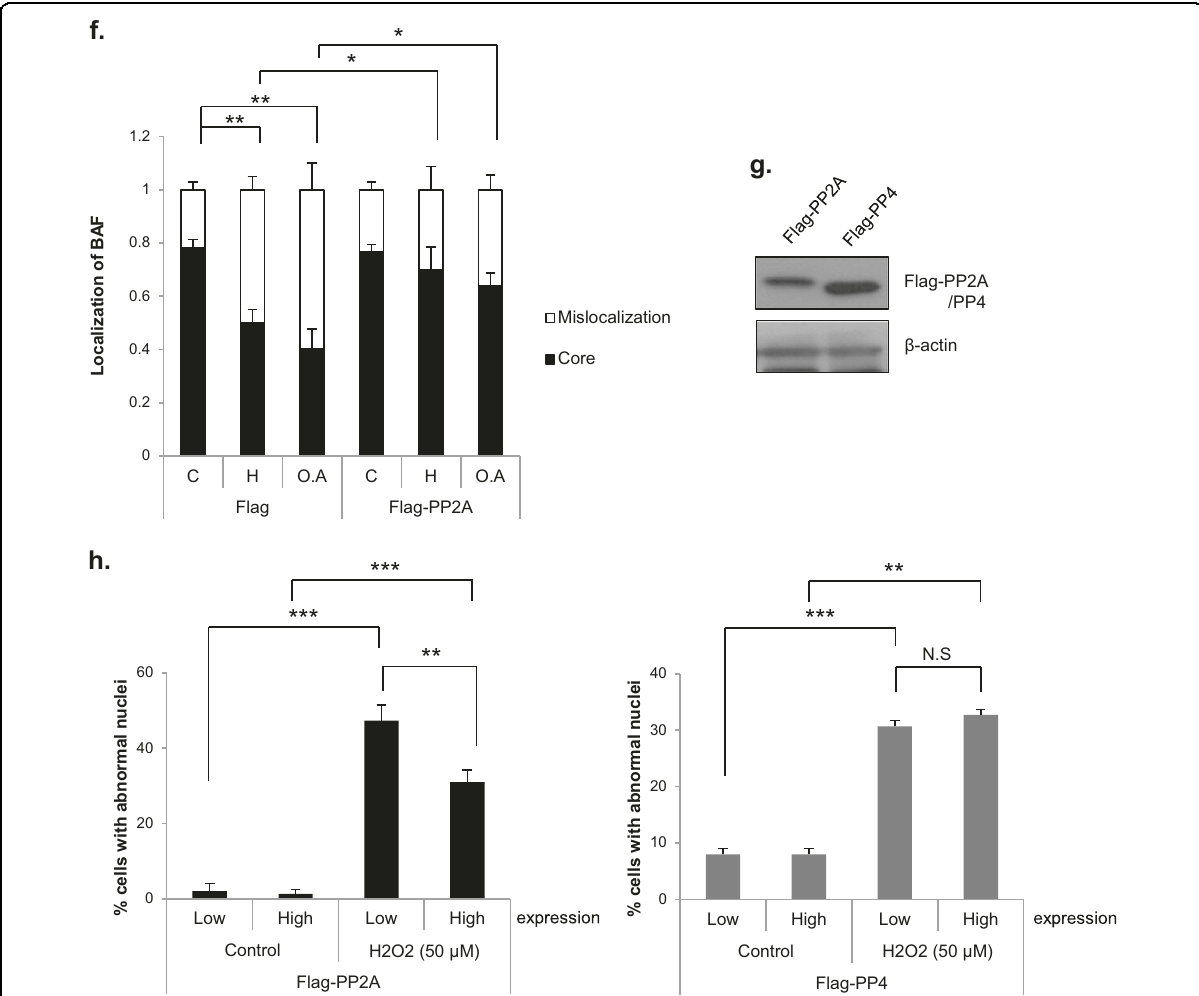
Fig. 7 Inhibition of PP2A activity by ROS during mitosis results in abnormal nuclear shapes via the mislocalization of BAF, a substrate of PP2A, during nuclear envelope reassembly. Schematic showing how the increase in H 2 O 2 during mitosis induces nuclear shape alterations. BAF localizes to the chromosomal core region during telophase through dephosphorylation by PP2A, and the constituents of other nuclear membranes are subsequently recruited around the chromosome to form a normal nuclear shape. However, increasing H 2 O 2 in mitotic cells induces the inhibition of PP2A activity. A decrease in PP2A activity seems to prevent BAF from being localized in the chromosome core region during telophase, which subsequently mislocalizes other proteins (e.g., Lamin A) that enter the core region in a BAF-dependent manner, thus resulting in the formation of an abnormal nuclear